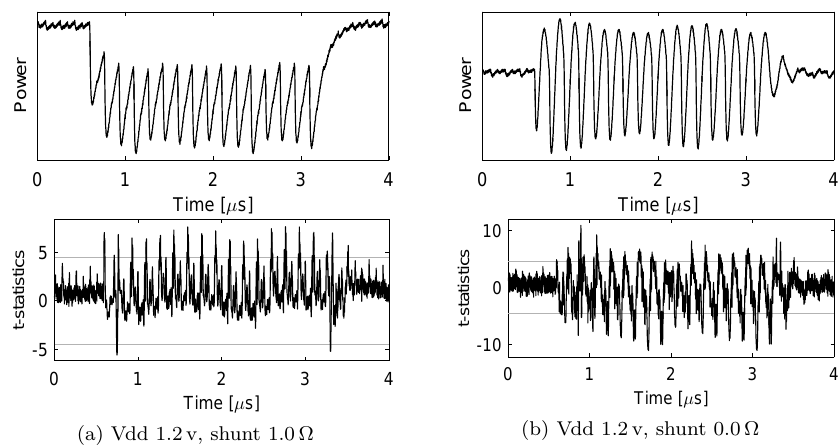
Figure 5: Case study 1: iterated_MC 1 , 4 , 3 MC modules, clock 6 MHz, room temperature, (top) sample power trace, (bottom) 1st-order t -test results using 100 million traces.